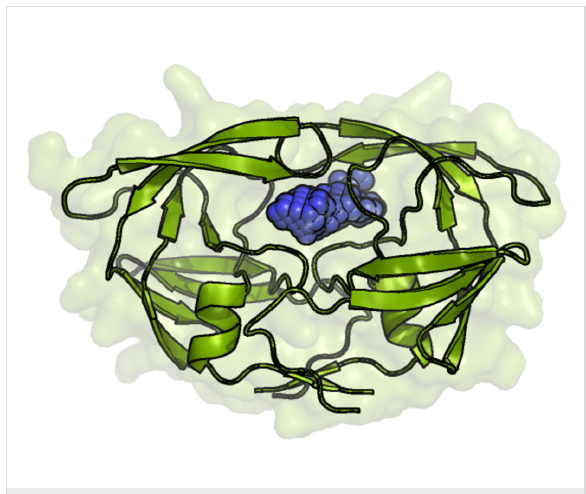
Figure 4: The best ligand binding site identified by SiteHound in HIV-1 protease. The ligand binding pocket is shown in blue spheres and is the known inhibitor binding site of HIV-1